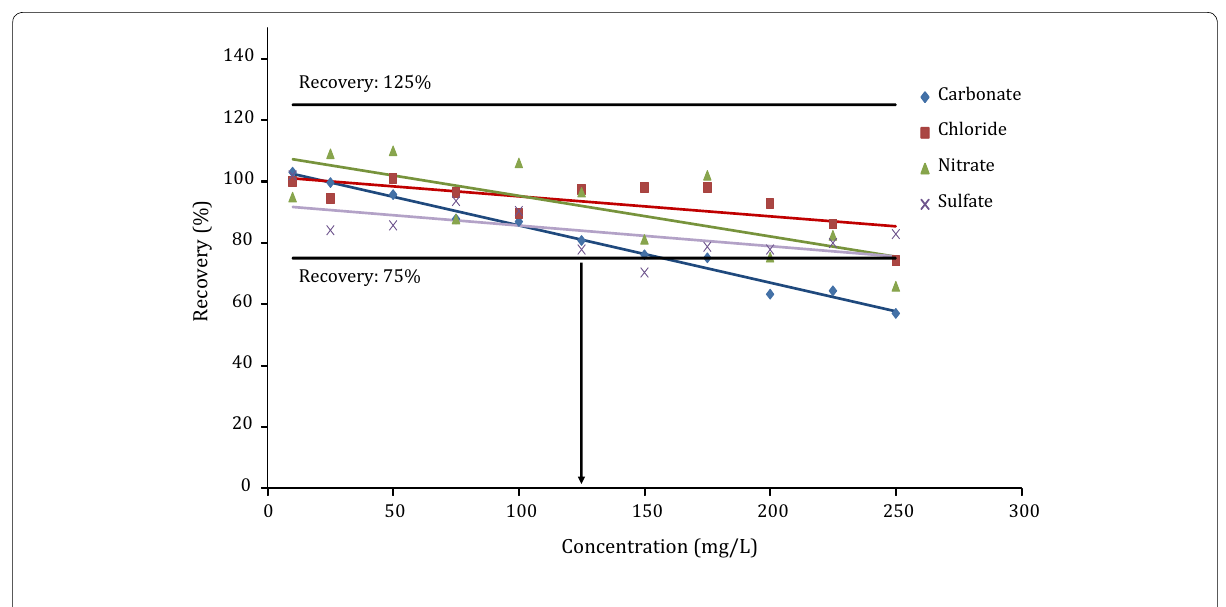
Table 5 Results for untreated and treated interlaboratory trial samples ILT